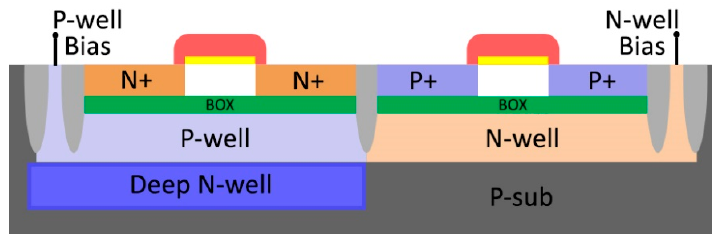
Figure 1. Cross sections of a 22 nm FD SOI transistor for a regular well configuration. All designs presented in this work used the regular well configuration with no back-gate biasing.